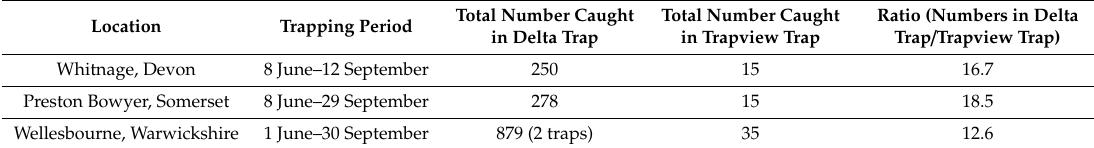
Table 3. Comparison of captures by Delta and Trapview traps in 2016.